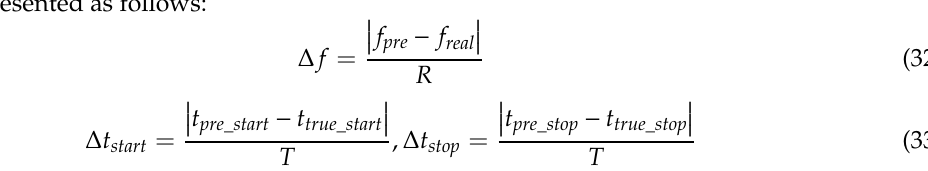
Table 2. The o ff set in the estimation of the various